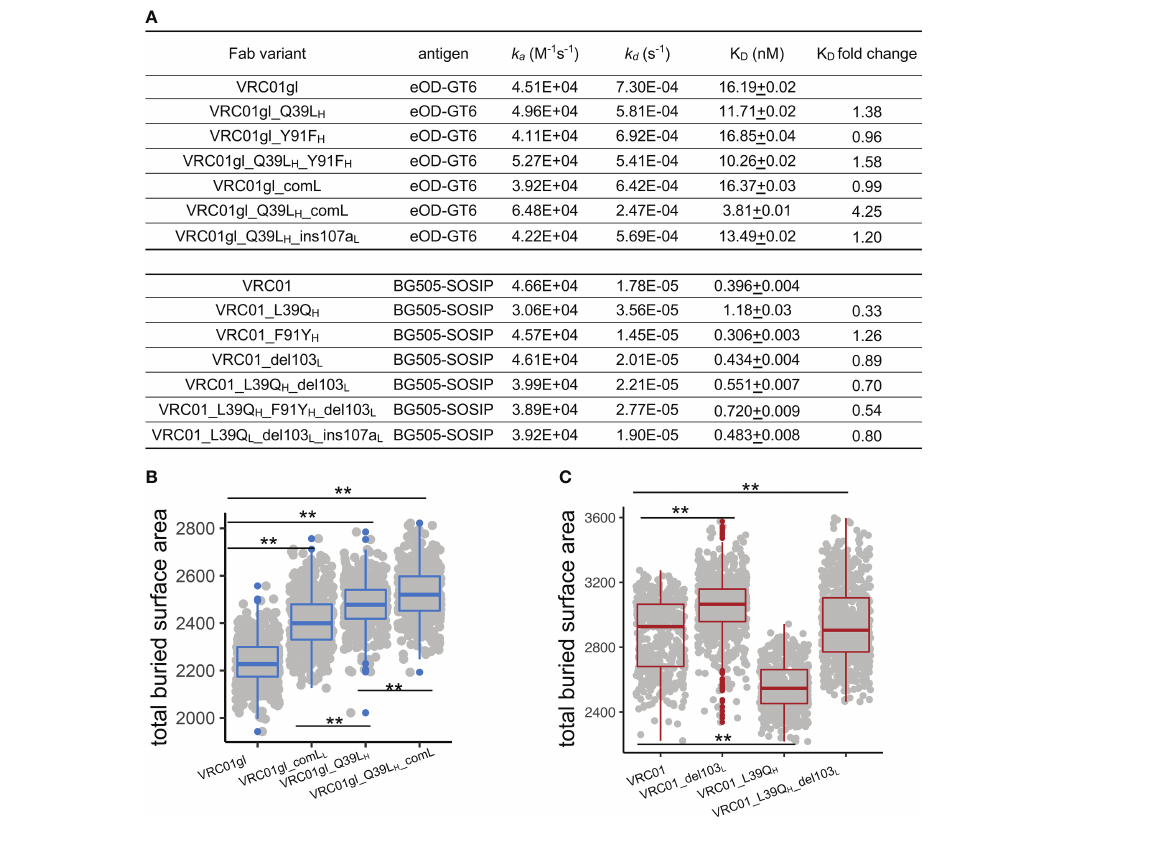
FIGURE 3 | FWR somatic hypermutations improve antigen-binding af fi nity by increasing bASA between antibody and antigen. (A) Antigen-binding af fi nity of VRC01gl and VRC01 mutants measured by SPR. Q39L H and comL improves VRC01gl binding af fi nity against eOD-GT6. L39Q H revertant reduces binding af fi nity of VRC01 against BG505-SOSIP. (B) Q39L H and comL increase bASA between VRC01gl and eOD-GT6. (C) L39Q H and VRC01_del103 L reduce bASA between VRC01 and gp120. Kolmogorov – Smirnov test is used to compare the signi fi cance of difference. P values less than 0.01 are labeled with two